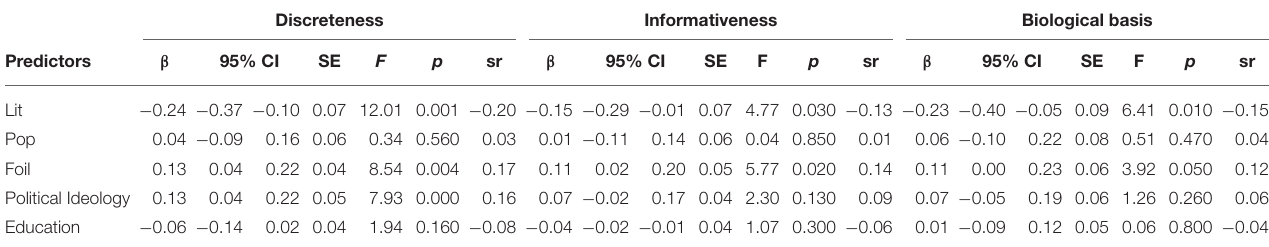
TABLE 2 | Multiple regression results (Study 2). Discreteness Informativeness Biological basis